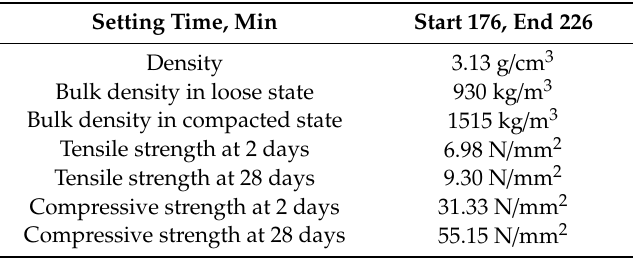
Table 1. Physical–mechanical characteristics of